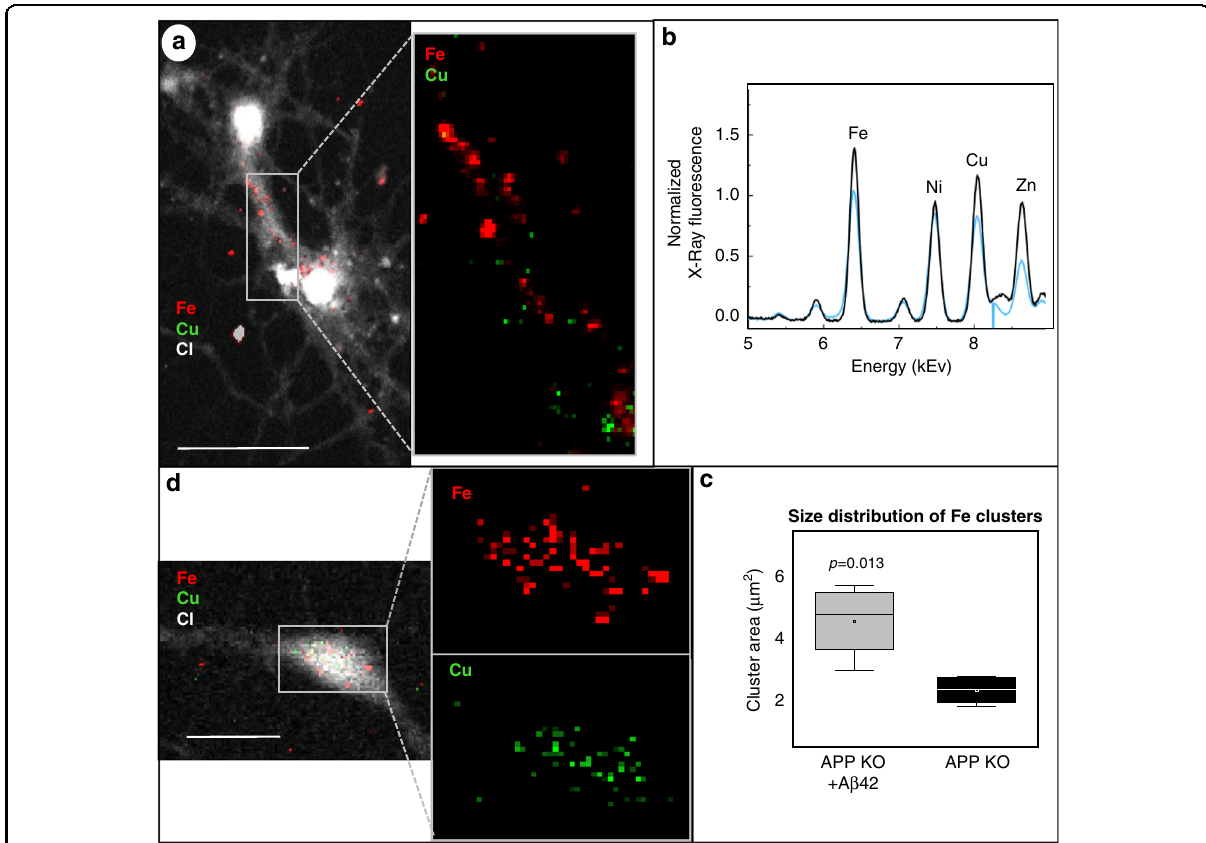
Fig. 3 Elemental distribution imaged by scanning X-ray fl uorescence nanoprobe in cultured primary neurons, a cellular model of AD. a Elemental distribution of Cl, Cu, and Fe in cultured APP-KO neurons incubated for 30 min with 5 × 10 − 6 M synthetic A β (1 – 42). Maps of Cl are used for neuronal identi fi cation. Pixel size is 500 nm; scale bar is 40 µm. b Averaged and normalized S-XRF sum-spectra of cultured mouse primary neurons. Blue spectrum corresponds to APP-KO treated with A β (1 – 42); black spectrum corresponds to untreated neurons. ( N = 3 cells per APP-KO embryo, from a total of 3 embryos). c Average area of the Fe clusters calculated per cell, including soma and neurites. d Iron distribution in untreated APP-KO primary neurons. Scale bar is 20